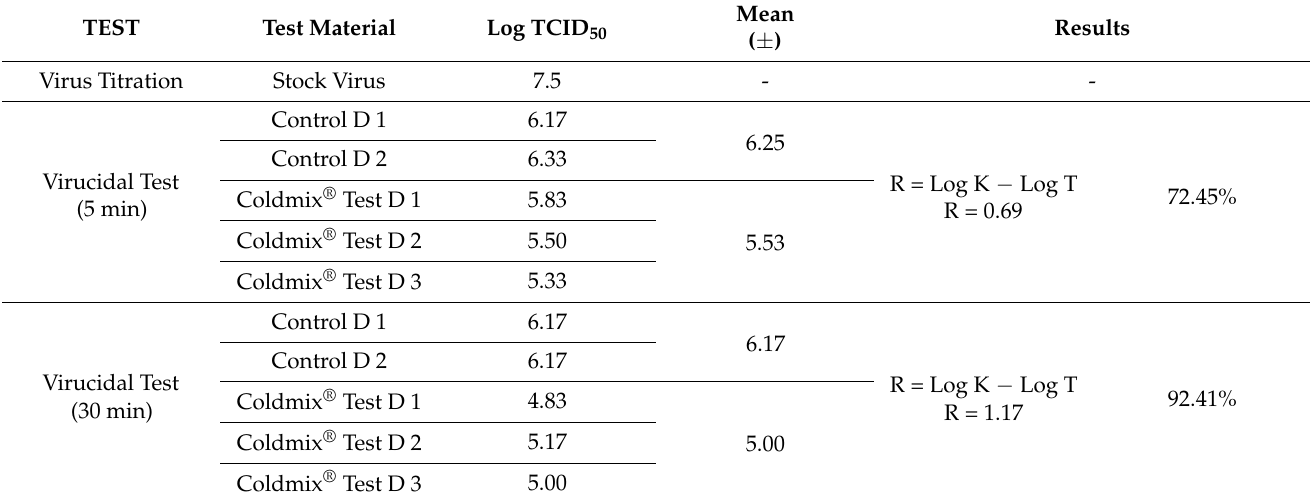
Table 1. The median tissue culture infective dose (TCID 50 ) of Coldmix ® and test samples against